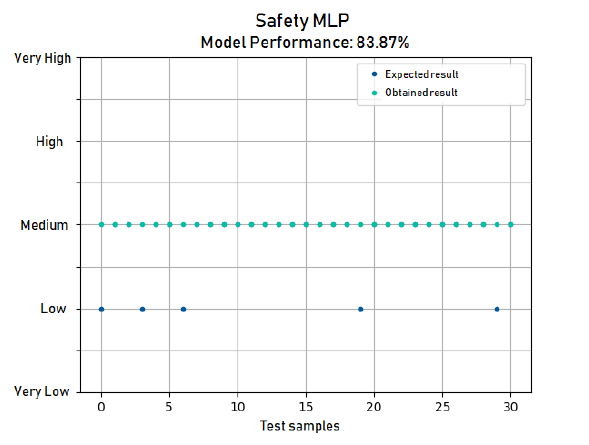
Figure 18. MLP for Safety. Model Performance: